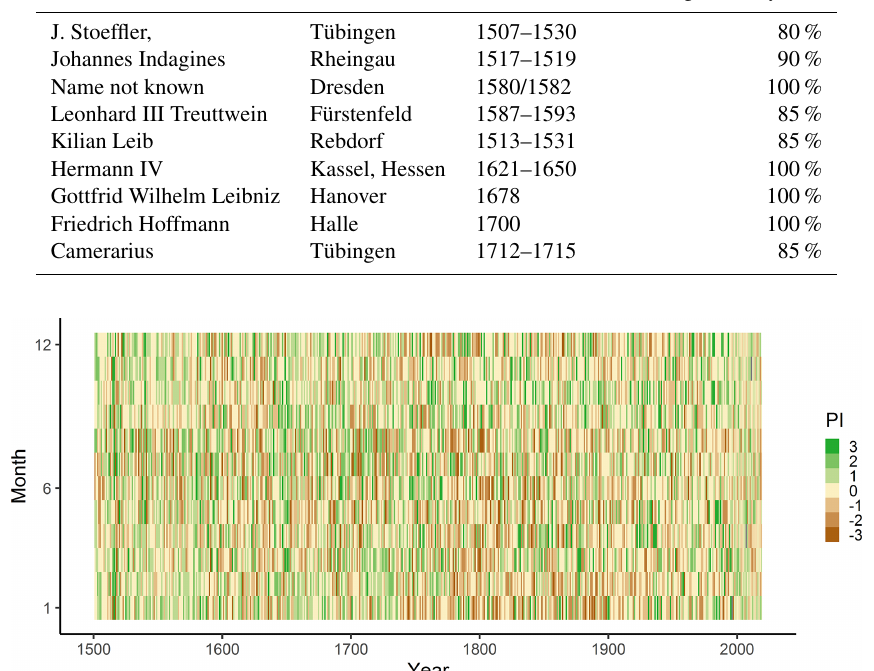
Figure 3. Summary of the monthly precipitation index (PI) for Germany from 1500 to